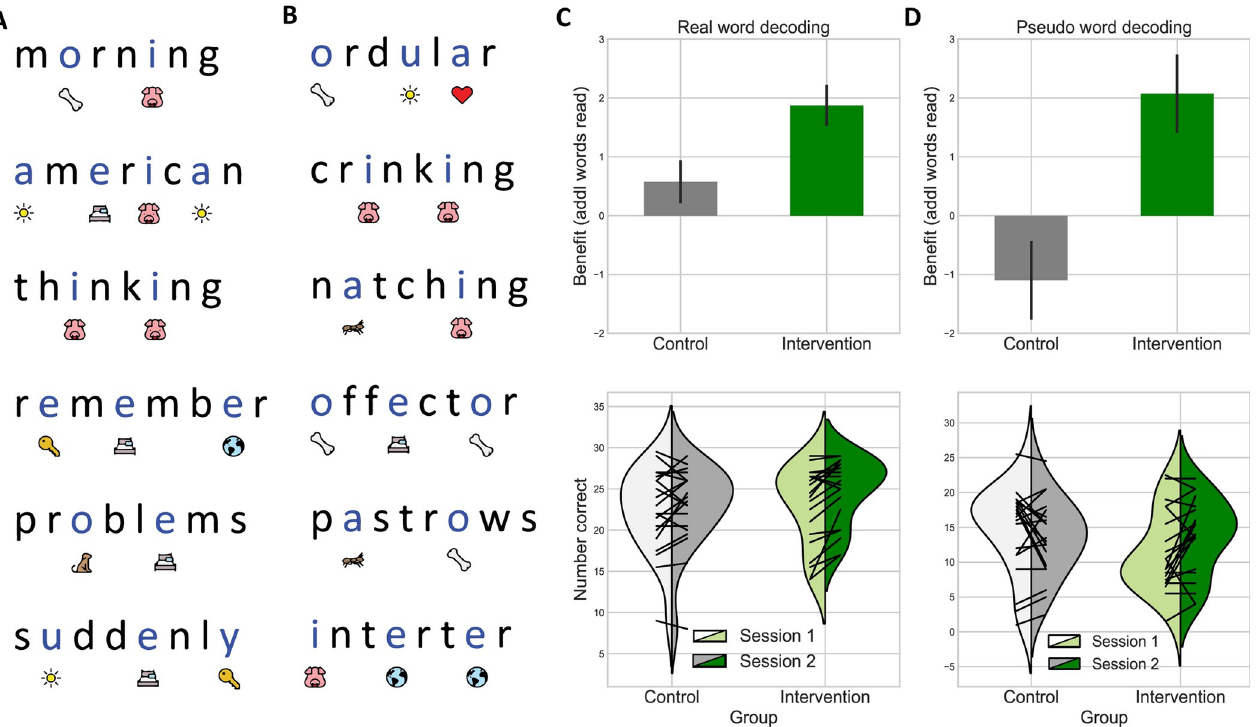
Fig 2. Untimed decoding performance on real and pseudo words. Example stimuli from the real-word (A) and the pseudo-word (B) lists with Sound it Out phonemic cues below the highlighted vowels. Bar plots show difference scores (number of words read correctly) from the first and second sessions for both the control and intervention groups on real word (C) and pseudo word (D) lists. Bar heights represent the additional words read on the second session. Error bars reflect +/- 1 SEM. Below the bar plots, violin density plots show group performance on these measures for both sessions with superimposed line plots of individual